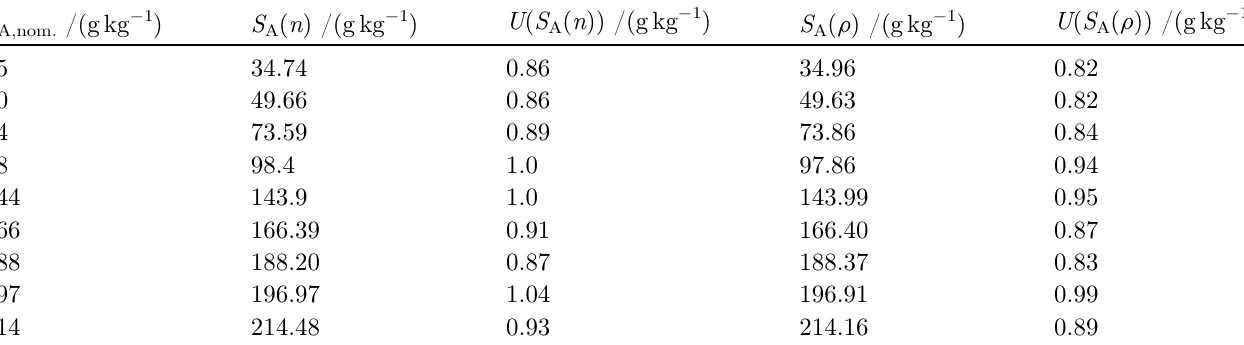
Table 2. Absolute salinity results of sodium chloride in ultrapure water solutions obtained from refractive index, S ( r ), measured values and corresponding expanded uncertainties, U ( k =2). and density, S A S /(g kg (cid:1) 1 ) A,nom.